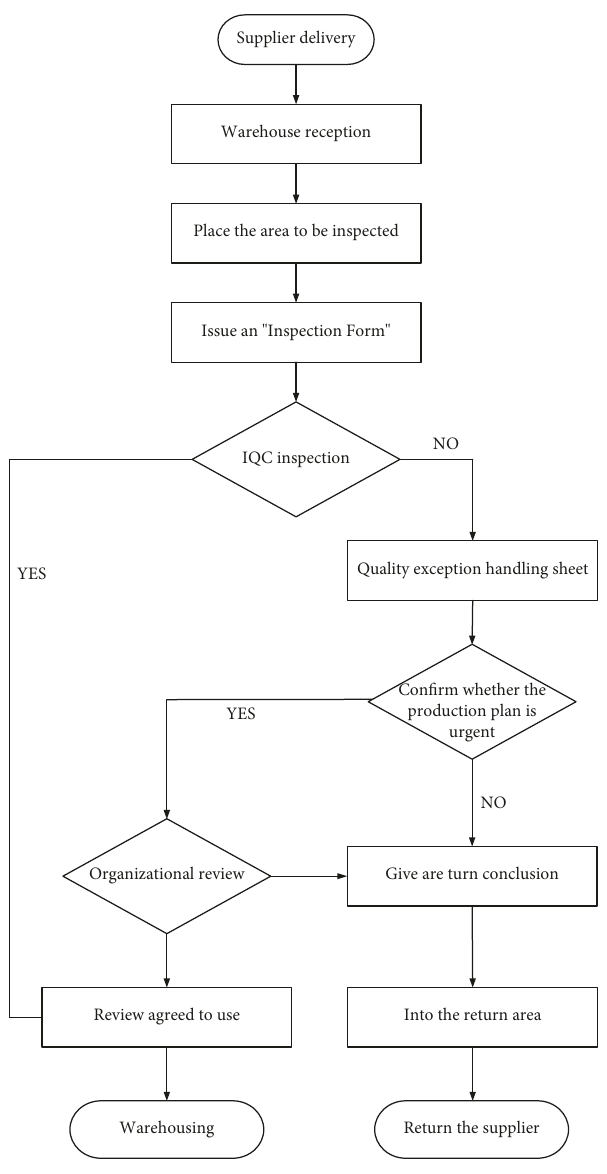
Figure 2: Incoming inspection